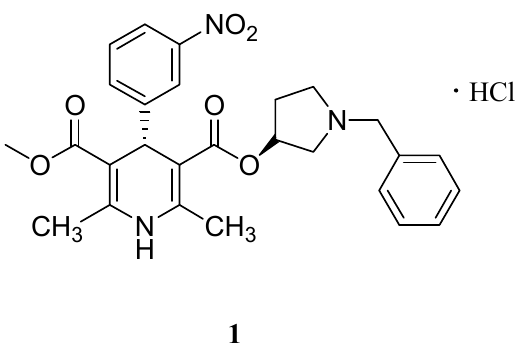
Figure 1. Structure of barnidipine hydrochloride ( 1